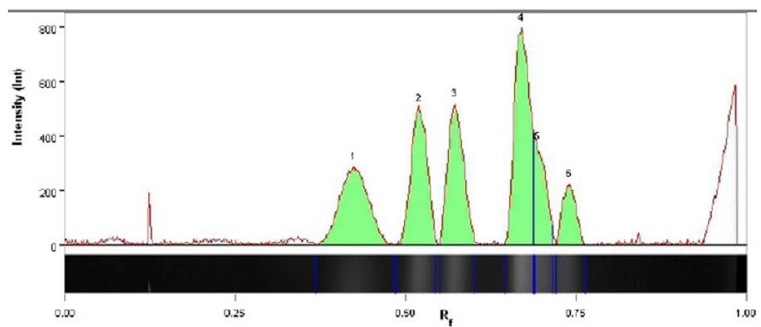
Figure 2. Pulsed field gel electrophoresis of Debaryomyces macquariensis strain D50 genomic DNA. The Hansenula wingei chromosomal DNA (Bio-Rad, Hercules, CA, USA) was used as size marker.